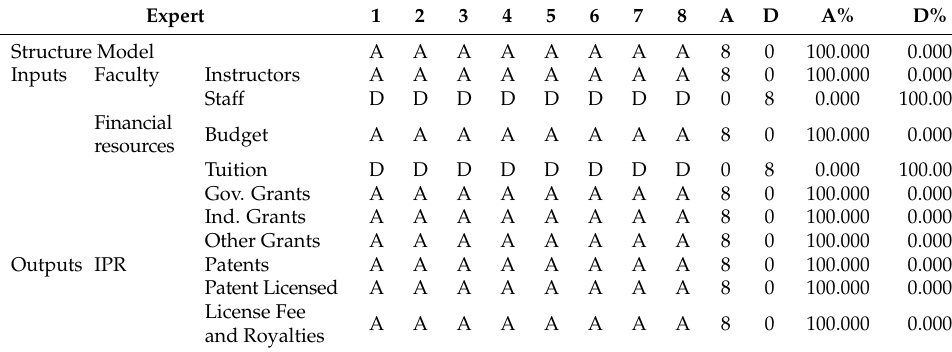
Table 2. The result from the questionnaire for the input and outputs.